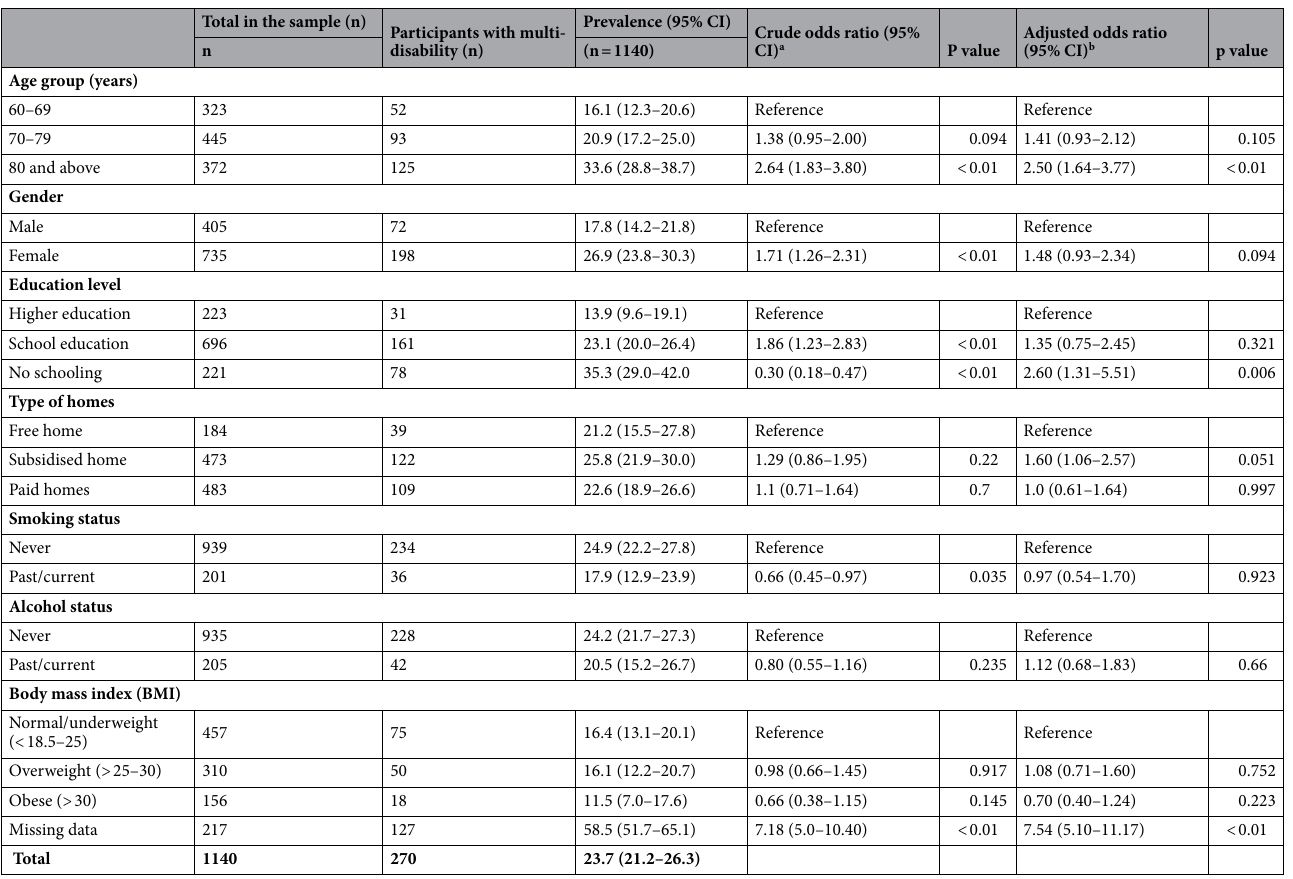
Table 3. Association of multi-disability (≥ 2 conditions) with sociodemographic and other characteristics (multiple logistic regression analysis) ; a Based on simple logistic regression with multi-morbidity as the outcome variable. b Based on multiple logistic regression with multi-morbidity as the outcome and all the predictors entered at the same time.